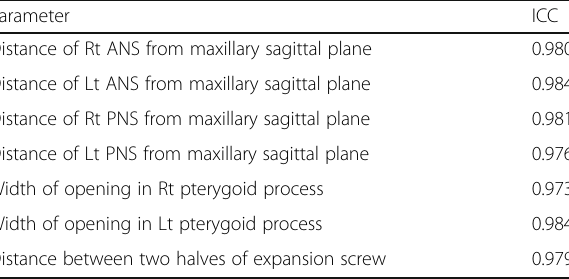
Table 5 Intra-class correlation coefficients (ICC) of the parameters. Rt ANS right half of anterior nasal spine, Lt ANS left half of anterior nasal spine, Rt PNS right half of posterior nasal spine, Lt PNS left half of posterior nasal spine, Rt right, Lt left